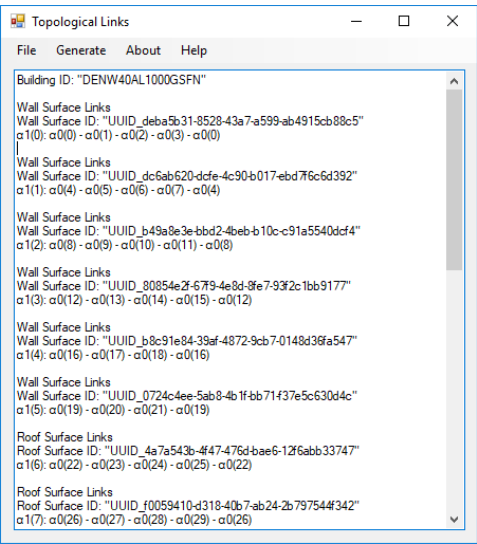
Figure 11. a-0 links for Dataset B